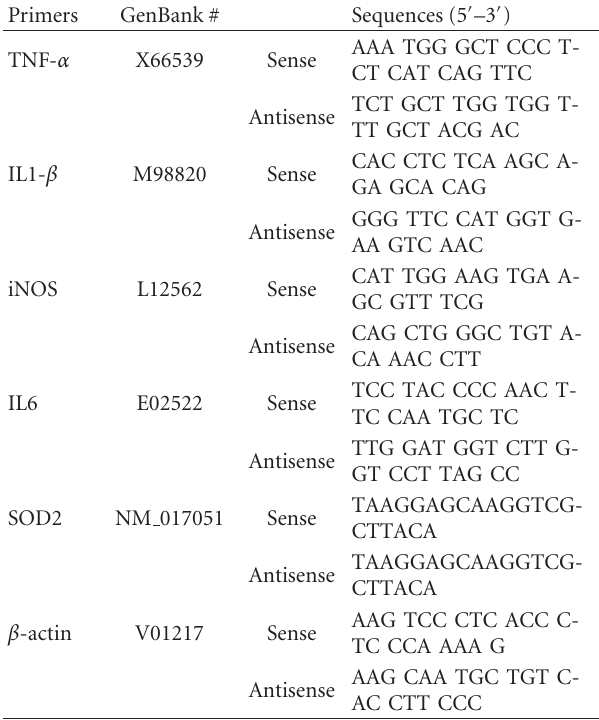
Table 1: Details of primer sets